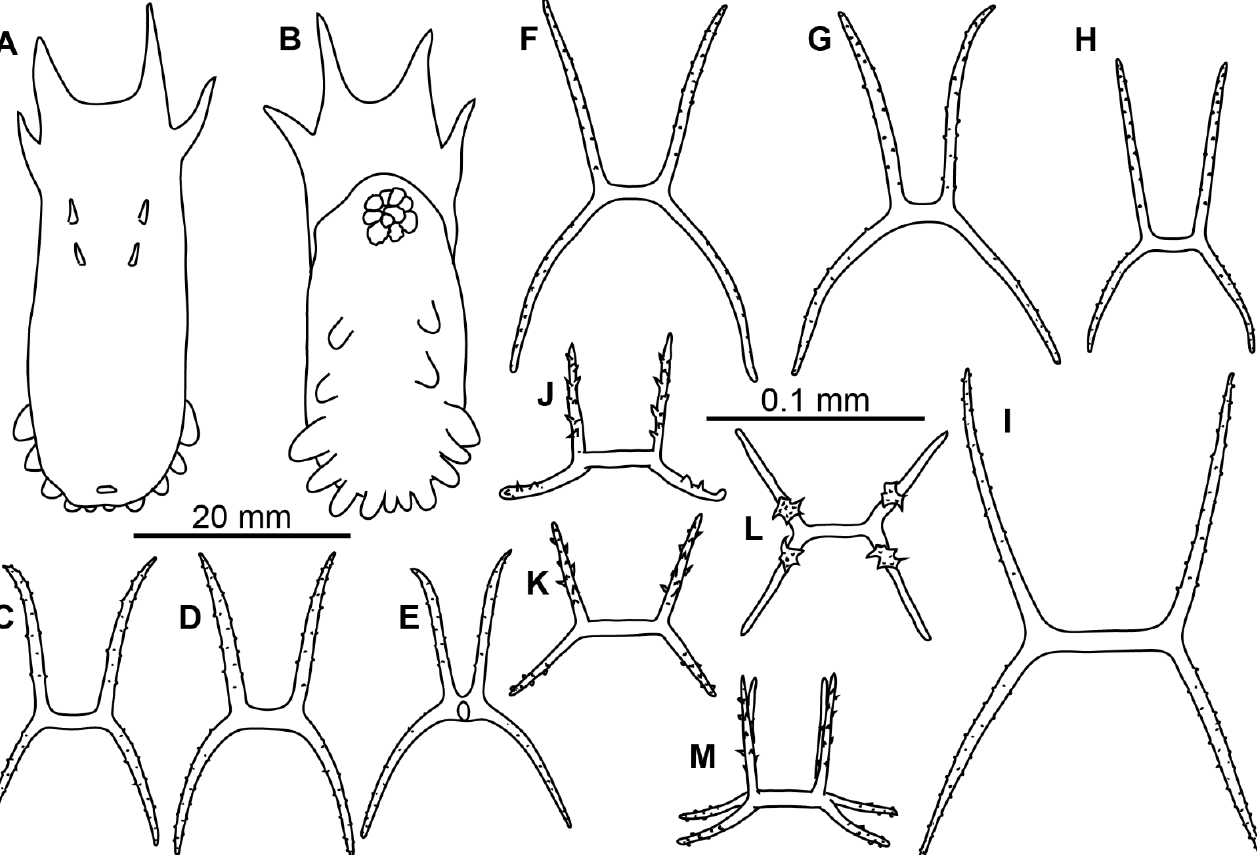
Figure 5. Peniagone cf. purpurea , RV Sonne , St. 01-13: ( A , B ) dorsal and ventral view, ( F – I ) dorsal ossicles, ( J – M ) ventral ossicles. ( C – E ), syntype of Elpidia purpurea NHM 83.6.18.4, dorsal ossicles. ( C – M ) scale 0.1 mm; pair of arms and apophyses omitted on ( C – J ).